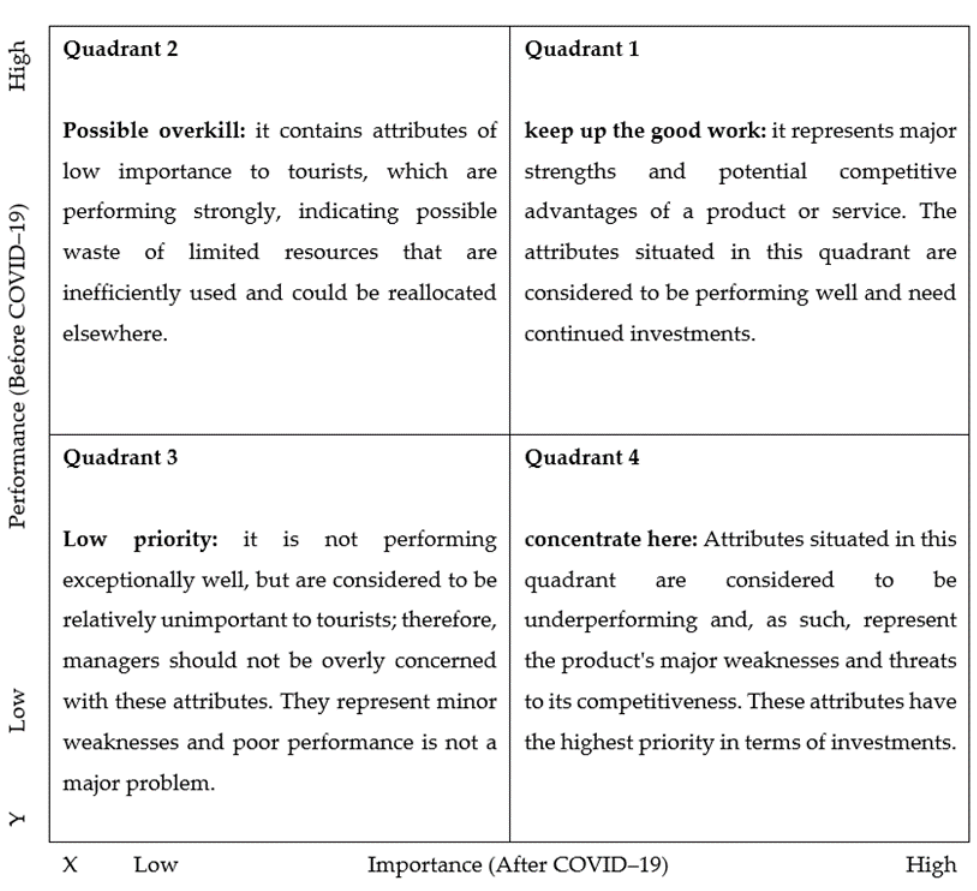
Figure 4. The importance–performance analysis model. Note: IA = Importance (After COVID-19), PB = Performance (Before COVID-19).